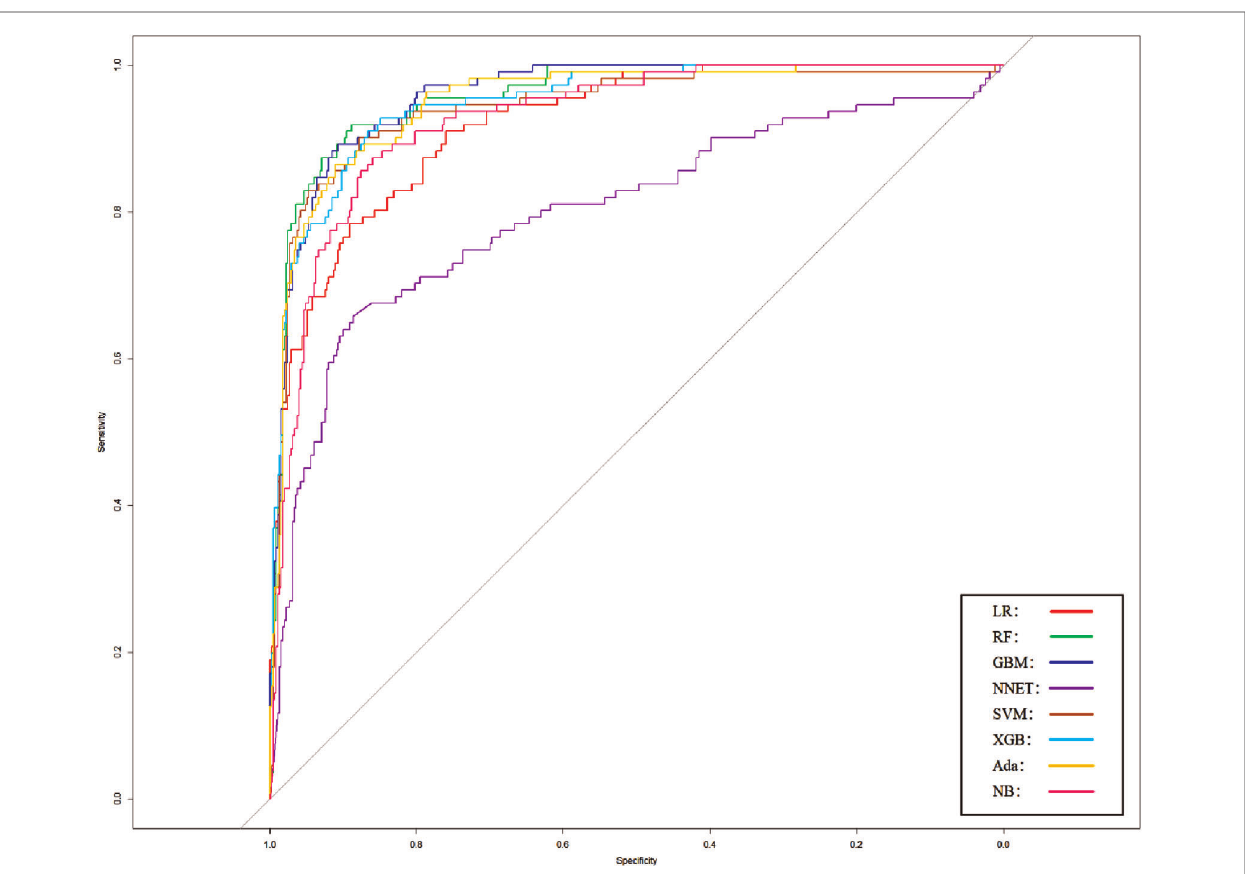
FIGURE 4 | Area under the receiver operating characteristic curve by different Model2 algorithms in the validation cohort. LR, logistic regression; RF, random forest; GBM, gradient boosting machine; NNET, arti fi cial neural network; SVM, support vector machines; XGB, eXtreme gradient boosting; Ada, adapting boosting; NB, naïve Bayes; Model2 was adjusted for GCS, glucose, sodium, chloride, SPO 2 , bicarbonate, temperature, white blood cell (WBC), heparin use, SOFA score, creatinine, bun, platelet, age, marital, trauma, lymphocytes, calcium, race, and cerebrovascular disease.